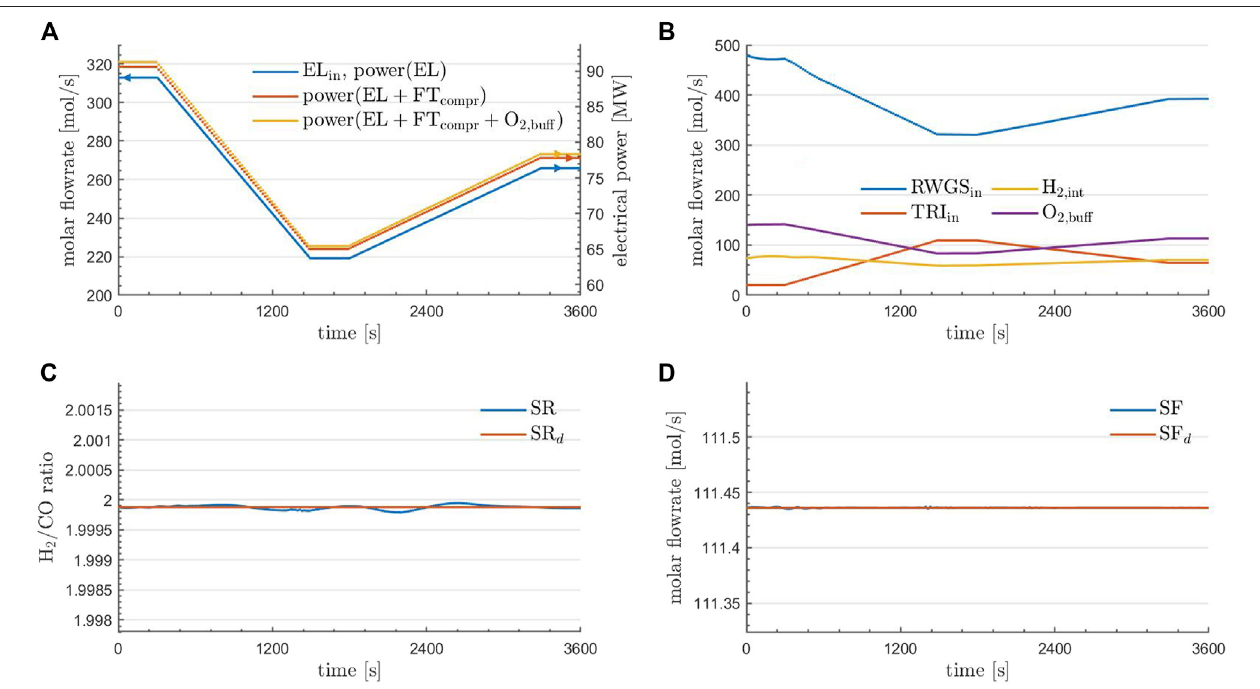
FIGURE 4 | Prescribed dynamic in fl ow to the EL unit of the plant (A) . RWGS and TRI in fl ow as well as H 2 -integration and the accumulation of O 2 in the buffering device at optimality (B) . Obtained and desired syngas ratio (C) ,as well asobtained and desired syngas fl owrate (D) forthe optimal solution using parareal . (A) further contains the cumulative power demands within the control volume based on the calculations reported in Section 5.3.2